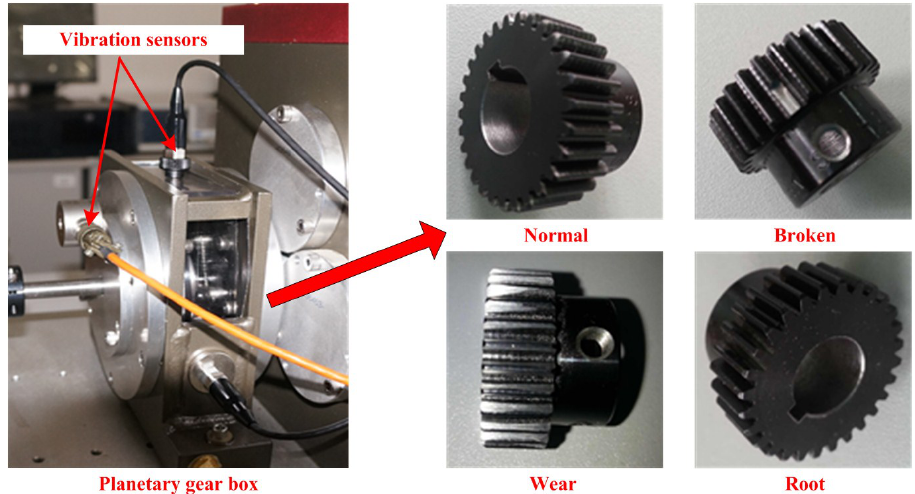
Figure 3. Planetary gear boxes and different fault sun gears.